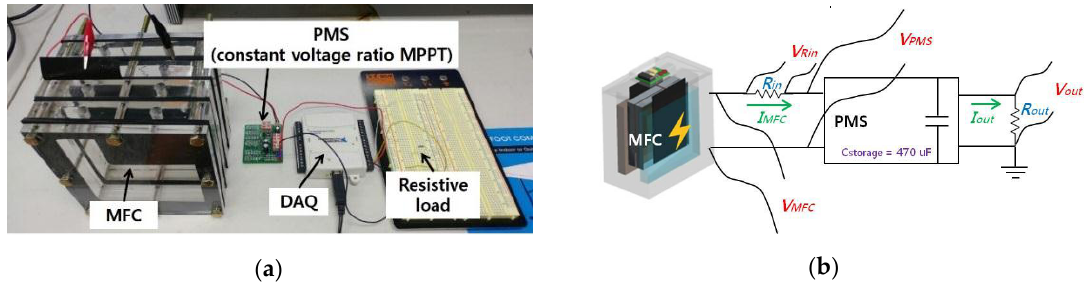
Figure 7. Experiments for examining the PMS performance on an MFC with different voltage ratios: ( a ) Experimental setup using the MFC prototype as an energy source; ( b ) Circuit schematic showing the measured voltages.